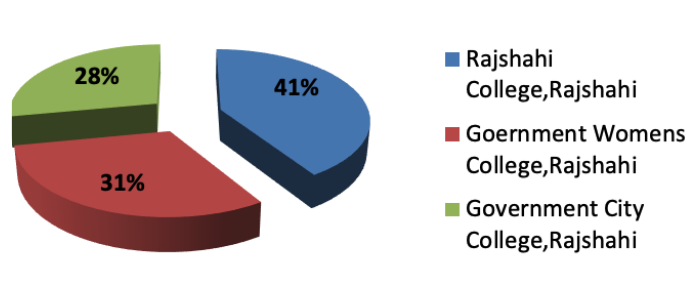
Figure 3 : The percentage of student who participate from the names of three BGCs.